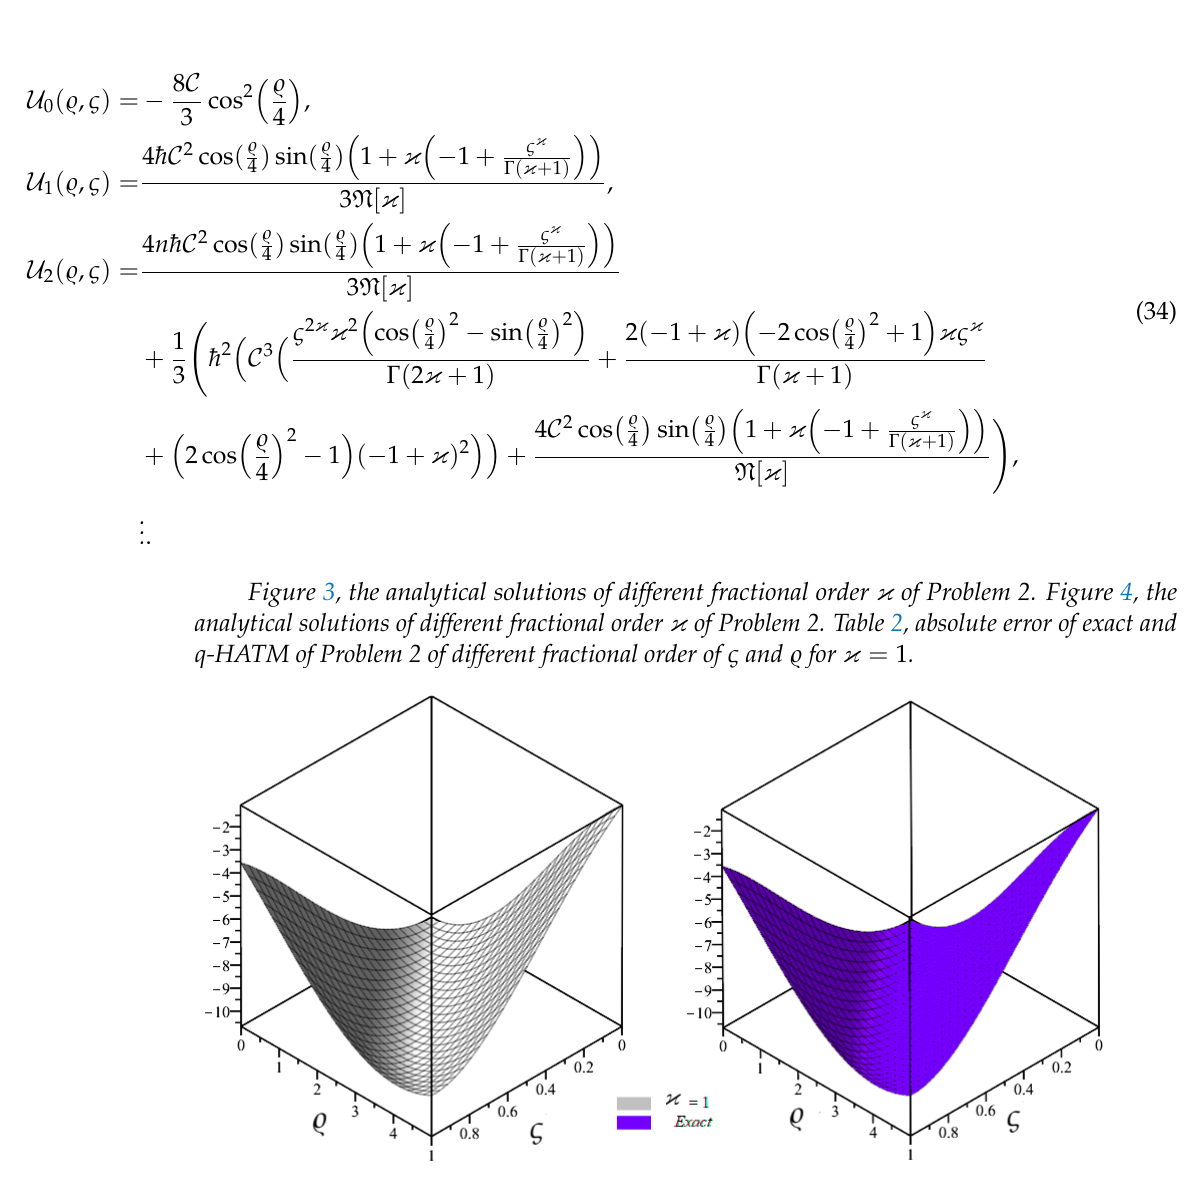
Figure 3. The exact and analytical solution graph of Problem 2. Table 2. The absolute error of exact and q-HATM of Problem 2 of different fractional order of ς and (cid:36) for κ =